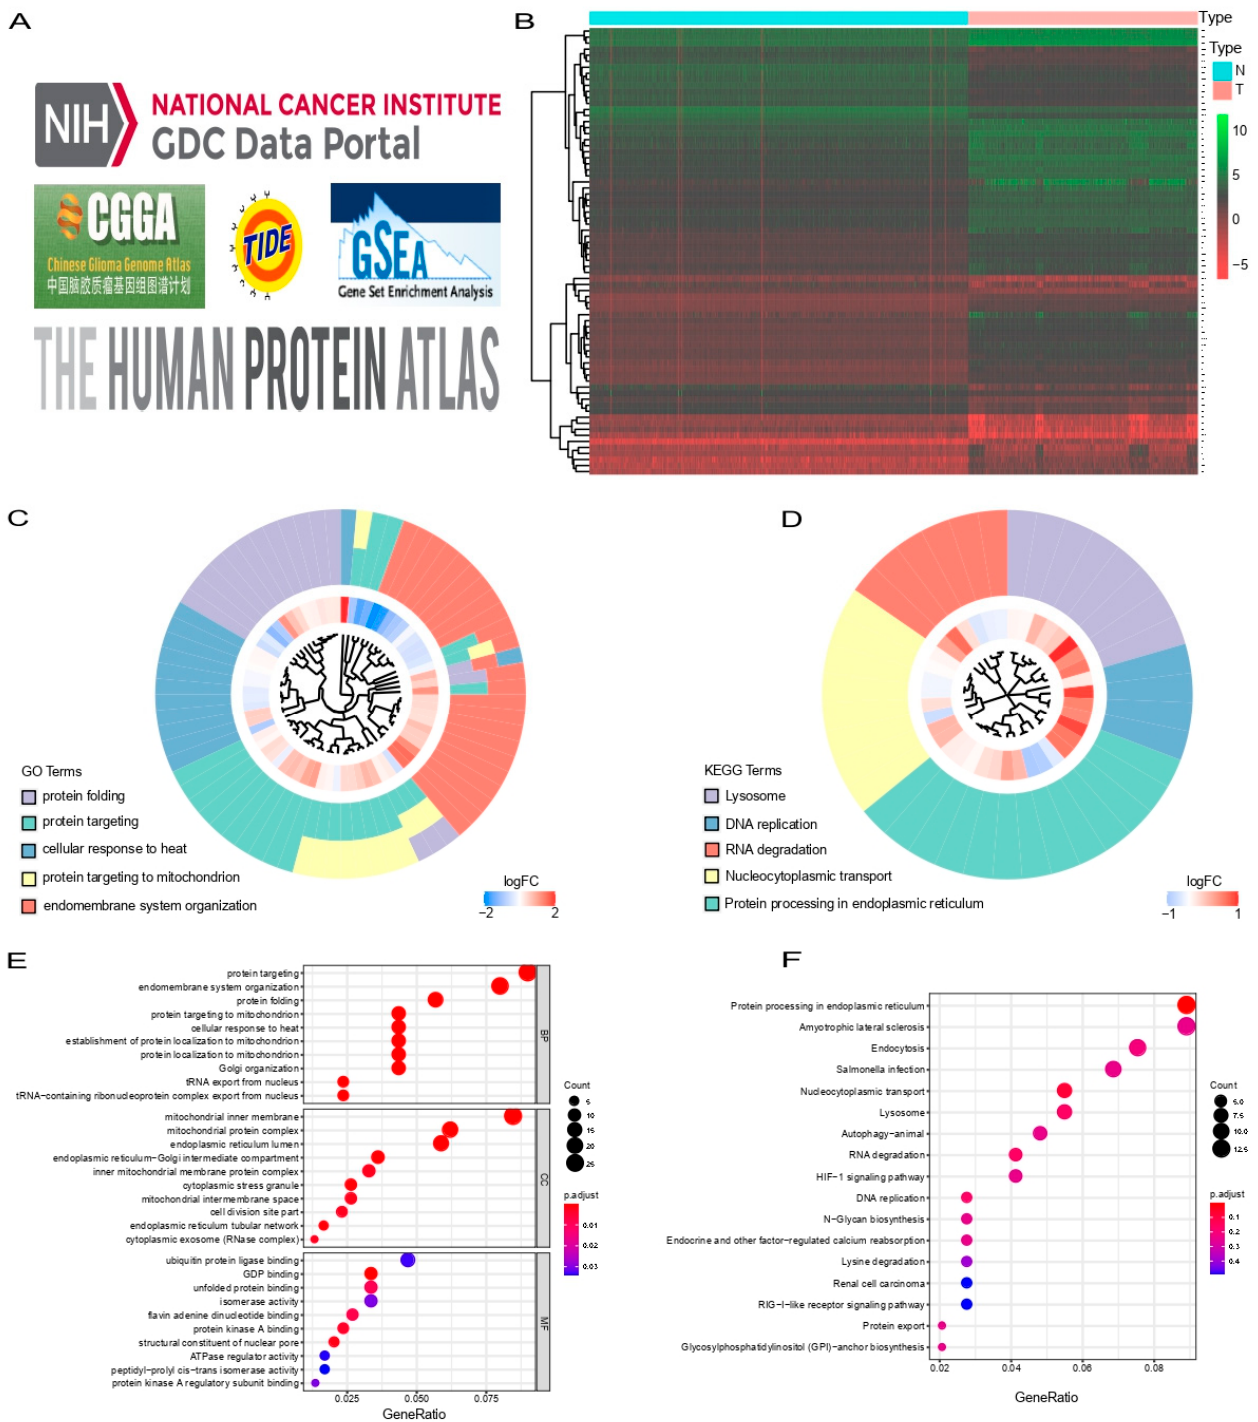
Figure 1. Identification of DEGs and biological characteristics of these genes by GO enrichment analysis and KEGG pathway analysis. ( A , B ) Heatmap ( A ) and a volcano plot ( B ) of 74 DEGs in normal and glioma groups. The logFC is presented. ( C , E ) Results of GO enrichment analysis. ( D , F ) Results of KEGG pathway analysis. The larger the circle, the redder the color and the stronger the correlation. DEGs, differential expressed genes; GO, gene ontology; KEGG, Kyoto encyclopedia of genes and genomes.